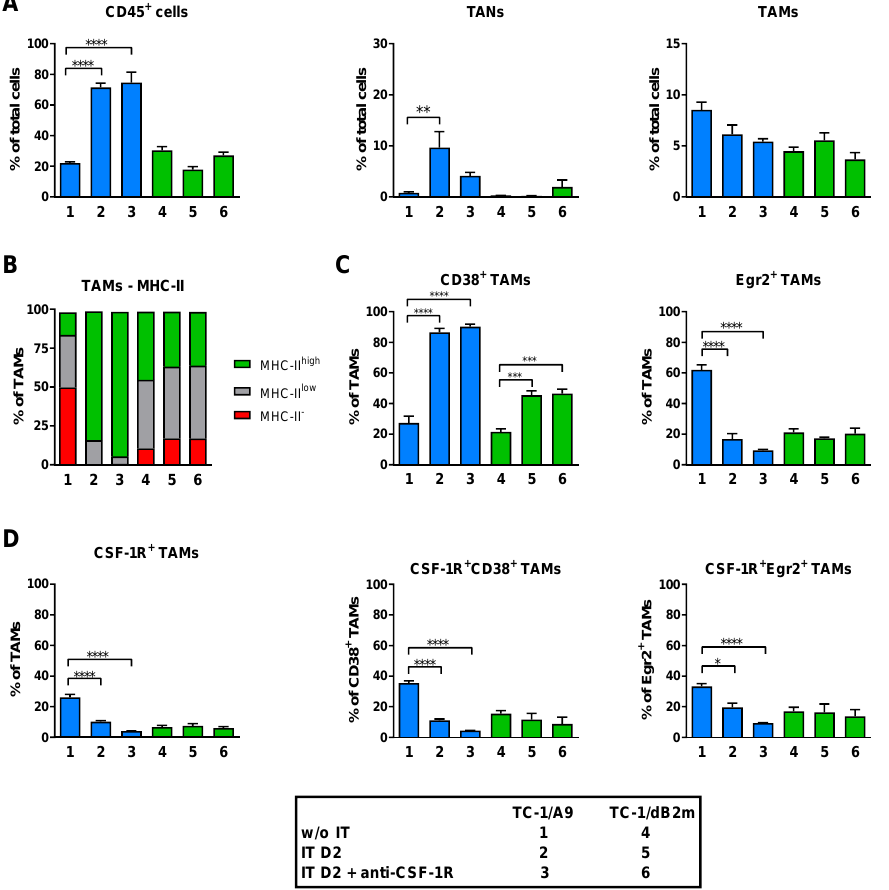
Figure 7. The effects of anti-CSF-1R on polarization and proportion of TAMs in tumors with down- regulated MHC-I expression. Mice were injected with tumor cells and subsequently treated with combined IT, consisting of DNA immunization by a gene gun, and i.p. injections of the ODN1826 adjuvant and monoclonal antibody anti-CSF-1R, as described in Material and Methods. On day 2 (D2) after completion of treatment, cells were isolated from tumors, and myeloid cells were analyzed by flow cytometry. Non-treated tumors were used as a control. ( A ) Infiltration of tumors with immune cells (CD45 + ), TANs (CD11b + Ly6G high Ly6C low ), and TAMs (CD11b + Ly6G - Ly6C - F4/80 + ). ( B ) Overview of the mean percentages of TAM subpopulations, as determined by MHC-II expression. ( C ) Analysis of M1 and M2 TAM frequencies using CD38 and Egr2 markers, respectively. ( D ) Frequencies of TAMs expressing CSF-1R. Bars: ± SEM; * p < 0.05, ** p < 0.01, *** p < 0.001, **** p < 0.0001.